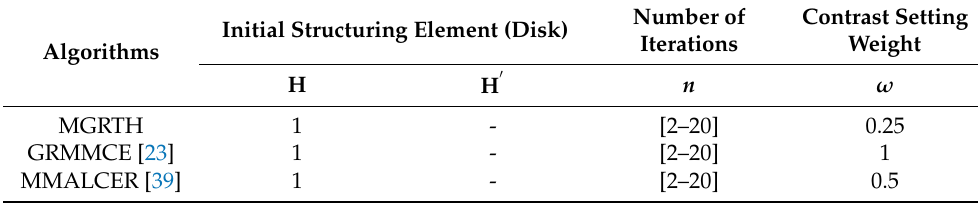
Table 2. Parameters of the algorithms based on multi-scale